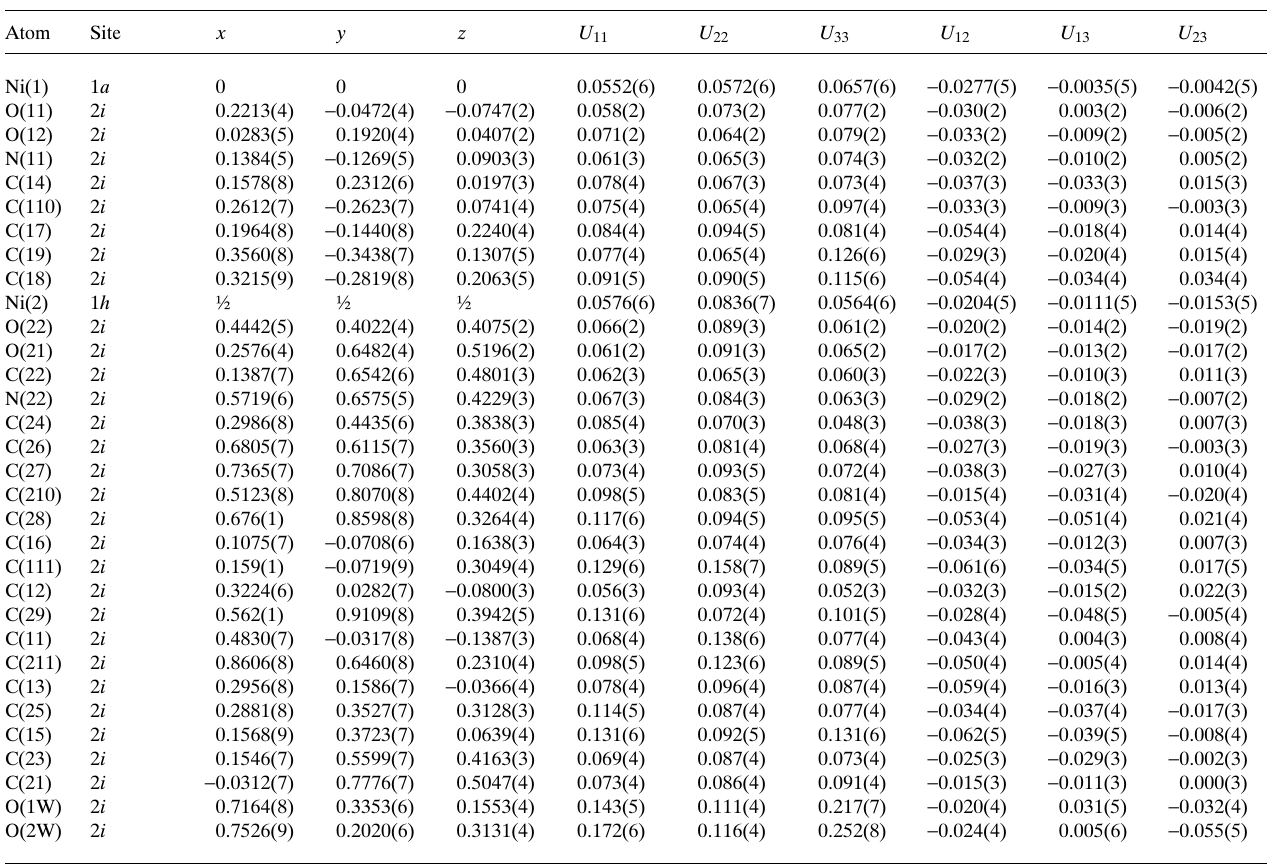
Table 3. Atomic coordinates and displacement parameters (in Å 2 ) .